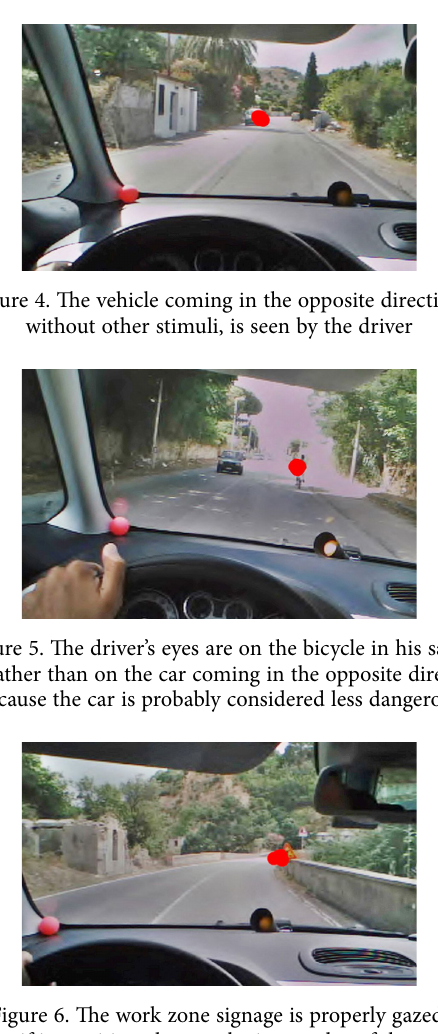
Figure 3. The fixation converged into the edge of the right curve (the vertical signs are ignored)